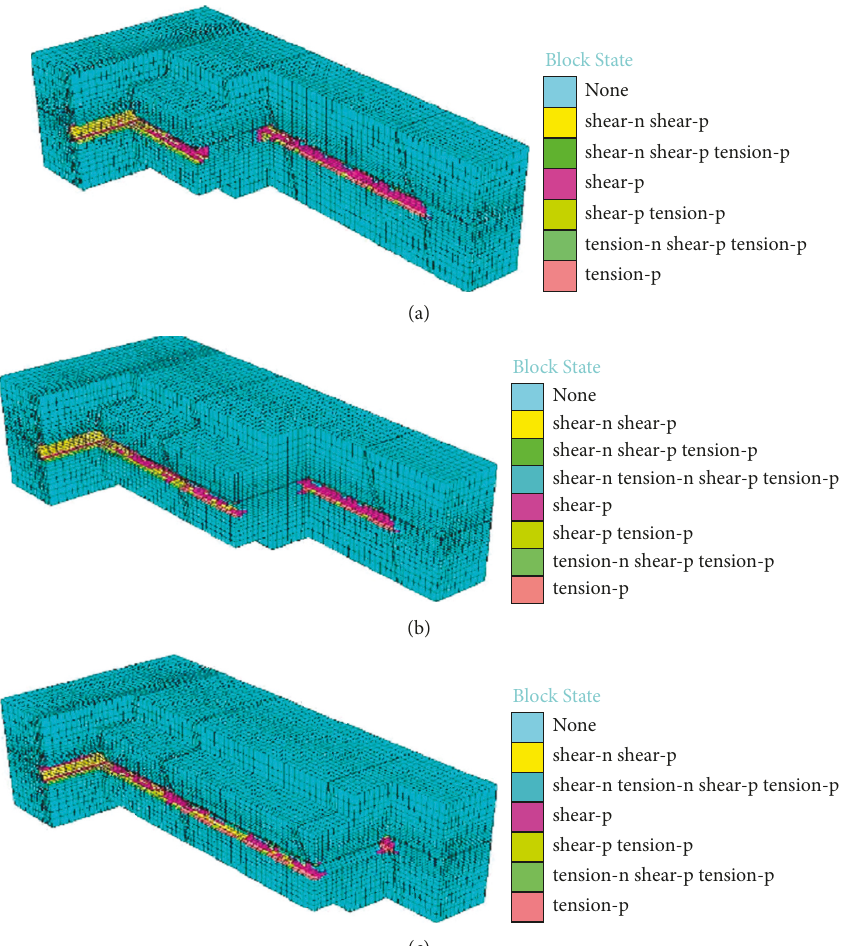
Figure 6: Damage models of surrounding rock in process of excavation. (a) Excavation for 15m. (b) Excavation for 30 m. (c) Excavation for